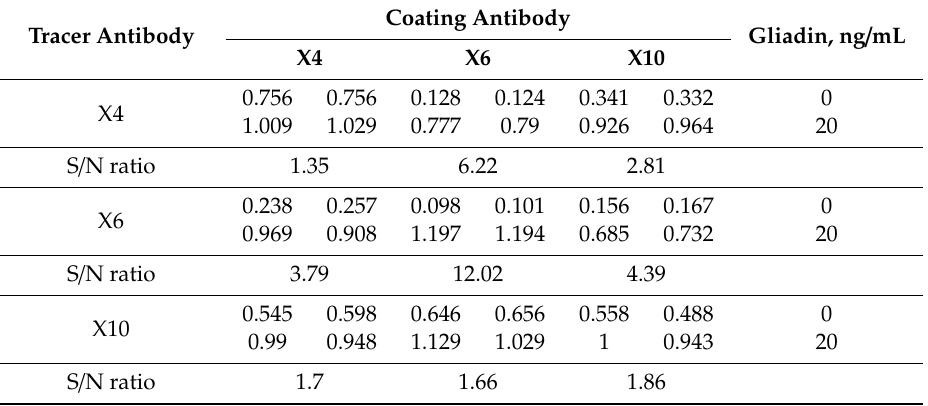
Table 3. OD values and S / N ratios obtained for various antibody